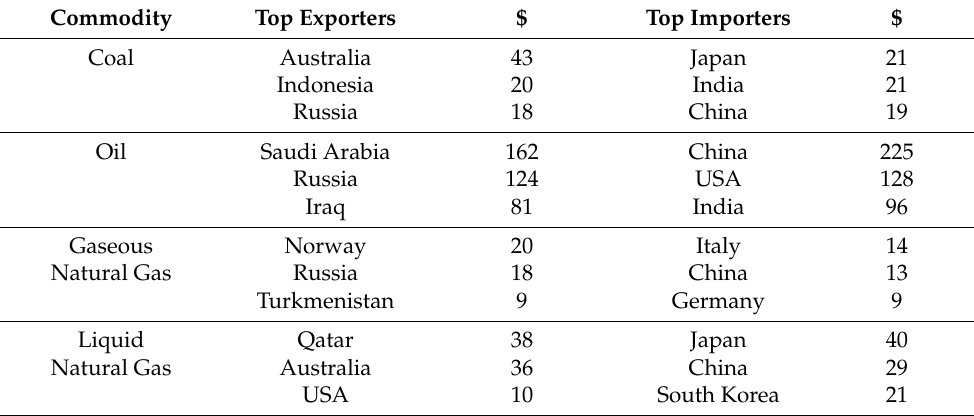
Table 1. Top 2019 importers and exporters by energy commodity in billions of US dollars.